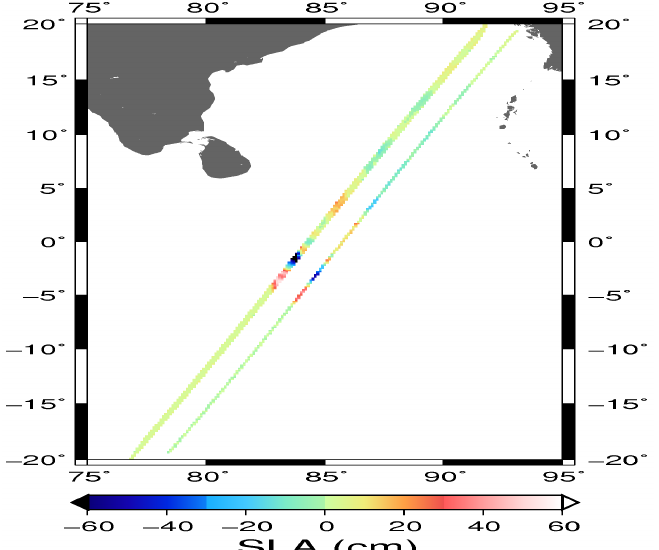
Figure 21. Simulated interferometer data on T/P platform with yaw steering and Poseidon 2 data to the right of